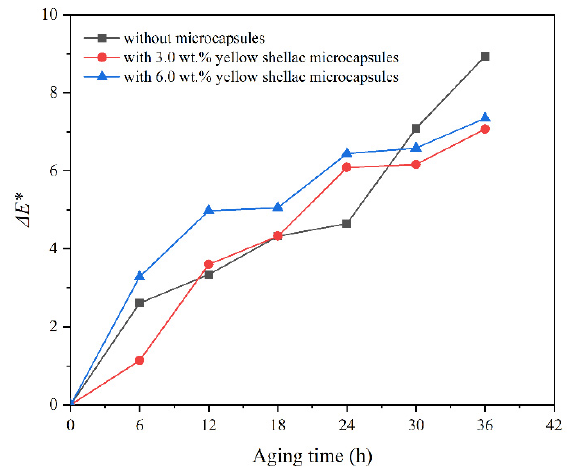
Figure 10. The Δ E* of the coating on Beli wood with purple shellac microcapsules after aging.